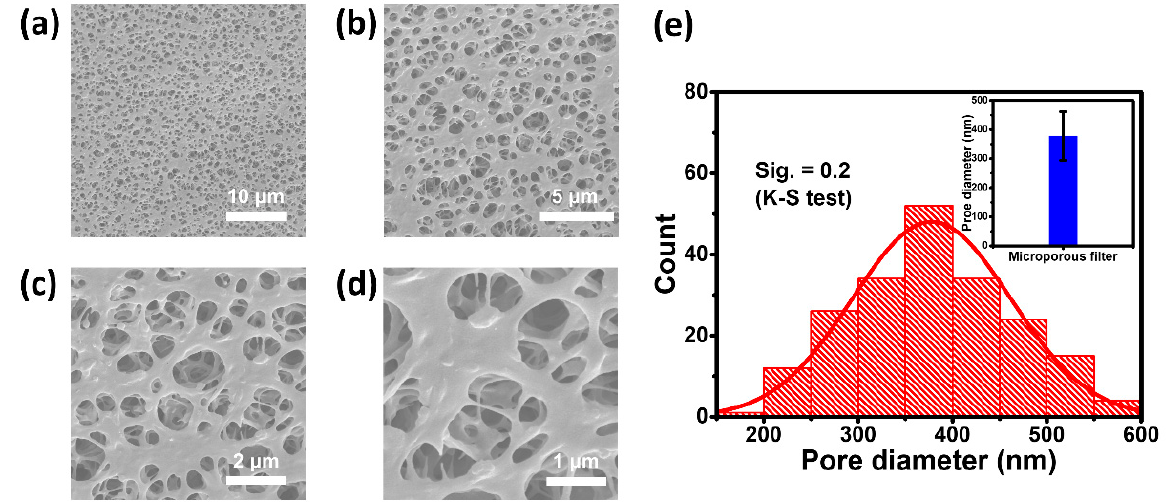
Figure 2. Characterization of the microporous membrane. ( a – d ) Typical SEM images of the microporous membrane at different magnifications. ( e ) Statistical results of the pore size distribution of the microporous membrane and its Kolmo ‐ gorov–Smirnov test results (the inset shows the mean and standard deviation of pore size of the microporous